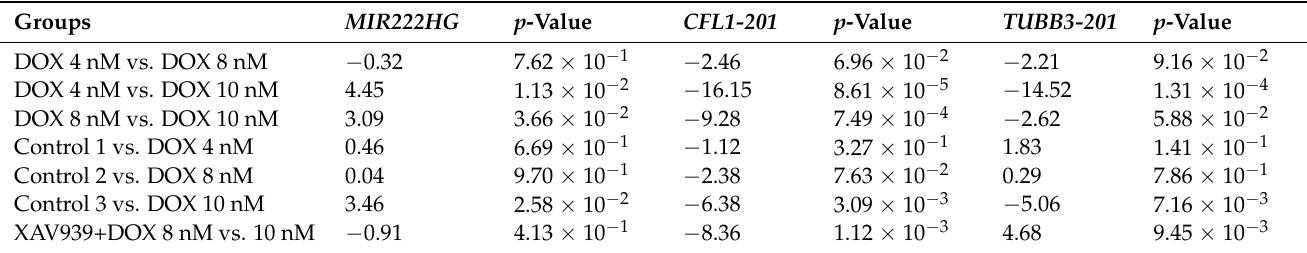
Table 10. Results of a t -test based on the relative expression of MIR222HG , CFL1-201 and TUBB3-201 between experimental groups of PC3